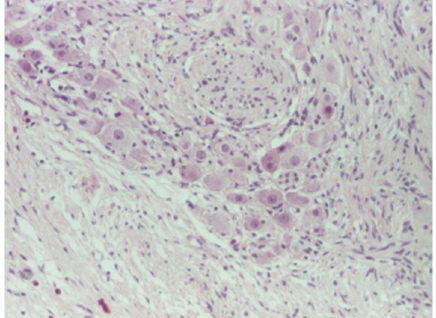
Figure 7. Mature ganglion cells admixed with stroma, HE × 100.